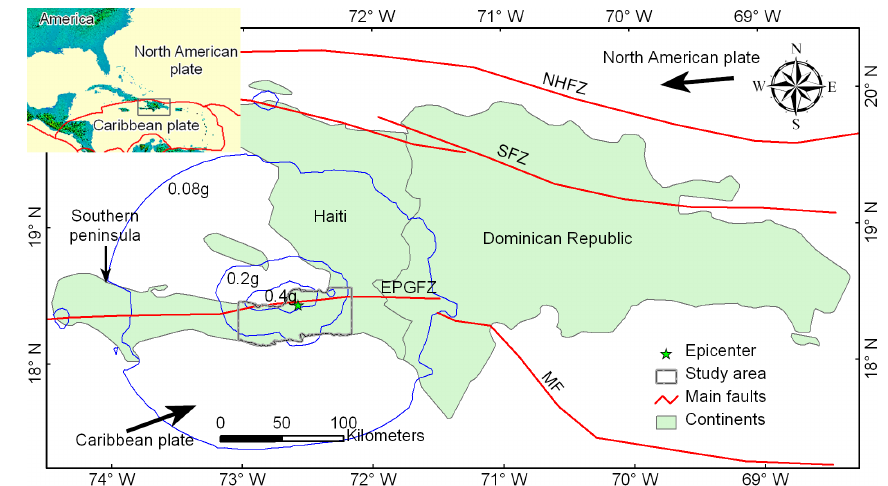
Figure 1. Location of study area, shown by the gray polygon. Thin blue lines indicate generalized PGA value contour lines. NHFZ: North Hispaniola fault zone; SFZ: Septentrional fault zone; EPGFZ: the Enriquillo–Plantain Garden fault zone; MF: Muertos